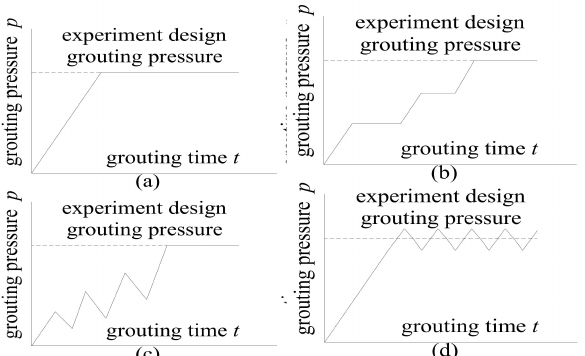
Figure 5. Variation forms of grouting pressure: ( a ) Linear growth; ( b ) Cyclic growth; ( c ) Fluctuation stability; and ( d ) Slow growth.